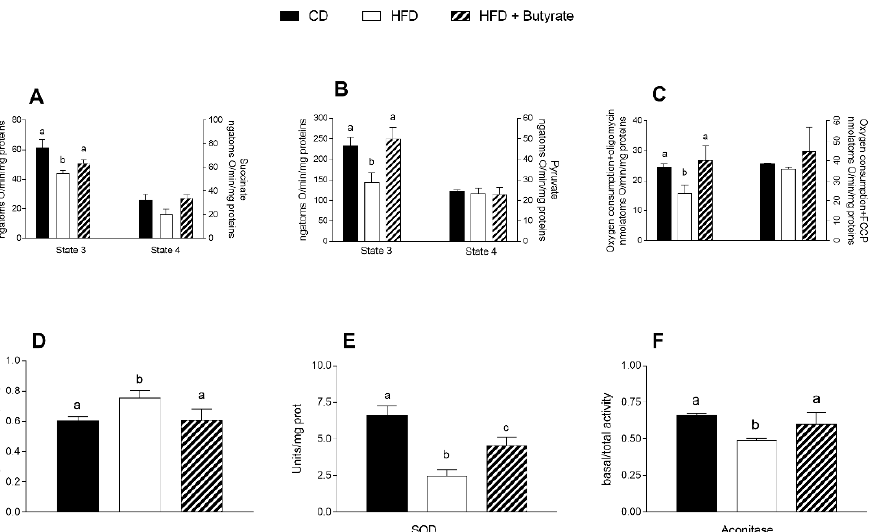
Figure 5. Effects of butyrate treatment on respiratory parameters of isolated mitochondria in the cerebral cortex in diet-induced obese mice: ( A ) Mitochondrial respiration rates measured in the presence of succinate and rotenone or ( B ) pyruvate and malate as substrates; ( C ) oxygen consumption in the presence of oligomycin or uncoupled by carbonyl cyanide 4-(trifluoromethoxy) phenylhydrazone (FCCP); ( D ) degree of coupling; ( E ) superoxide dismutase activities (SOD) and ( F ) aconitase activities are reported. Data are shown as means ± SEM from n = 6 animals/group. Different letters (a,b,c) on top of the bars indicate statistically significant differences ( p < 0.05) among groups.